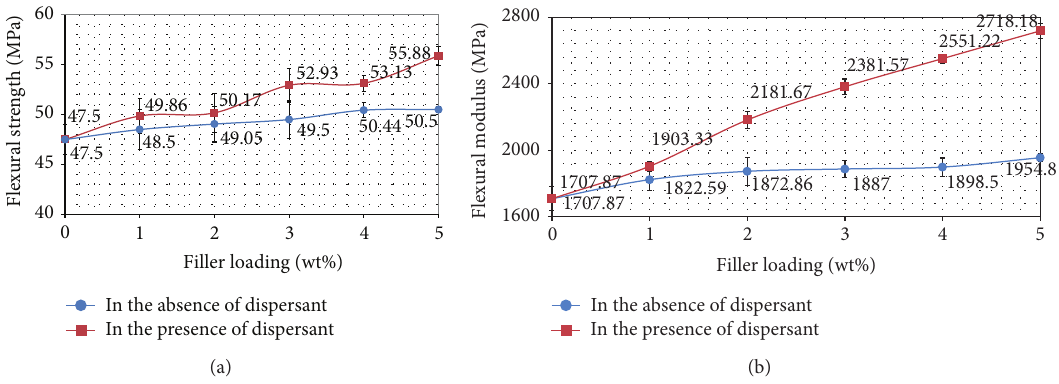
Figure 4: Flexural strength and flexural modulus of PP/nano 𝛼 -Al 2 O 3 composites at various